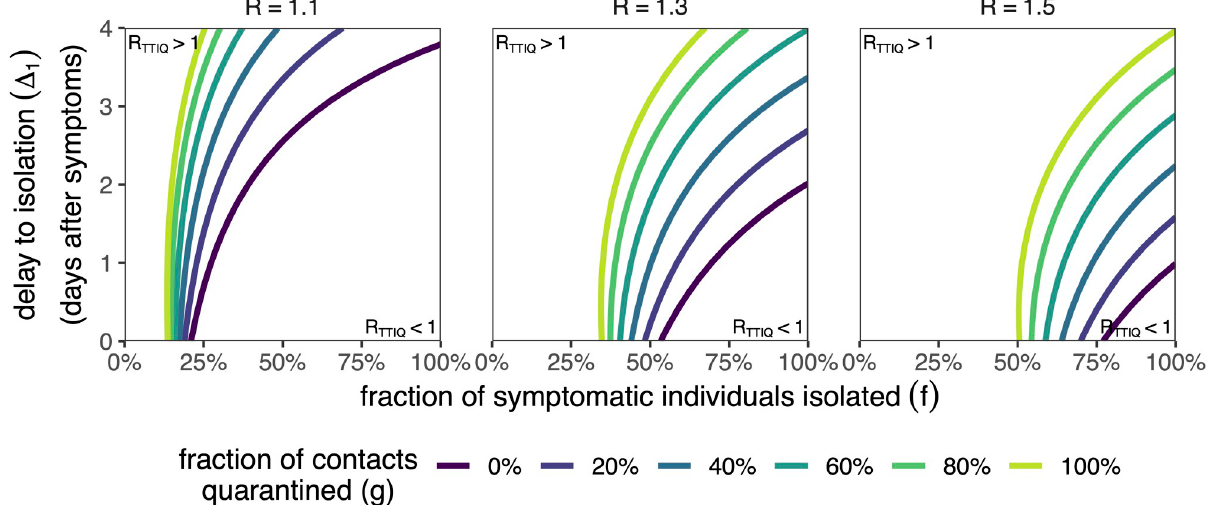
Fig 3. The impact of tracing & quarantine on the reproductive number. The impact of tracing & quarantine on the reproductive number R TTIQ as a function of the fraction of symptomatic individuals that are isolated ( f ; x-axis) and delay to isolation after symptom onset ( Δ 1 ; y-axis), for different contact tracing & quarantine success probabilities g (colour) across different baseline R values (columns). We fix Δ 2 = 2 days and τ = 2 days. The contours separate the regions where the epidemic is growing ( R TTIQ > 1; top-left) and the epidemic is suppressed ( R TTIQ < 1; bottom-right). The contours for g = 0 are equivalent to the contours in Fig 2. We fix the fraction of transmission that is attributed to asymptomatic infections to α = 20%. Asymptomatic individuals are not tested or isolated, but are subject to quarantine after contact tracing. We do not show confidence intervals for clarity of presentation. Data provided in S1